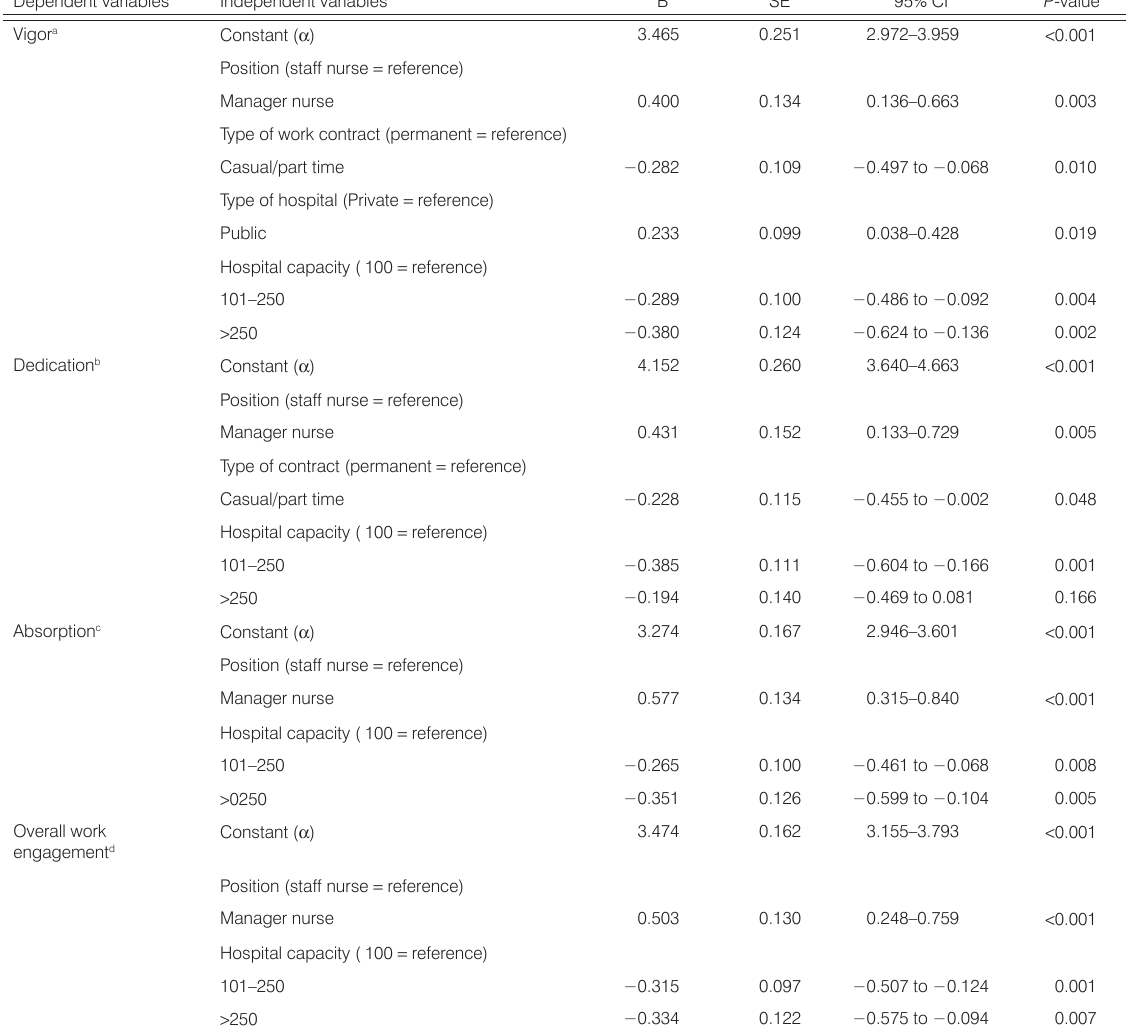
Table 3. Multiple linear regression analysis for the predictors of work engagement